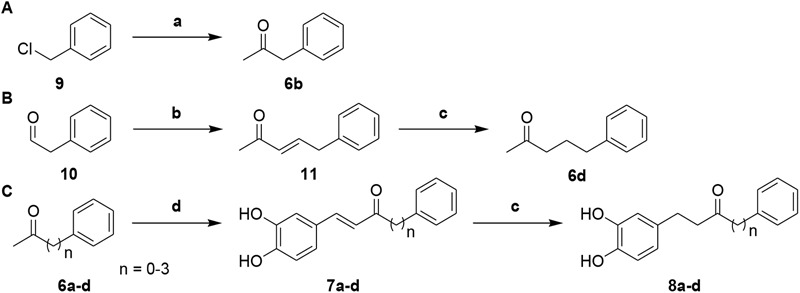
(A) Synthetic route to intermediate compound 6b. (B) Synthetic route to intermediate compound 6d. (C) Synthetic route to compounds 7a–d and 8a–d. Reagents and conditions: (a) tributyl(1-ethoxyvinyl)tin, PdCl2(PPh3)2, toluene, 100°C, 79%; (b) 1-(triphenylphosphoranylidene)propan-2-one, CH2Cl2, Δ, 87%; (c) 10% Pd-C, H2, EtOH, RT, 52-95%; (d) 3, 4-dihydroxybenzaldehyde, pyrrolidine, acetic acid, THF, Δ, 29-73%.